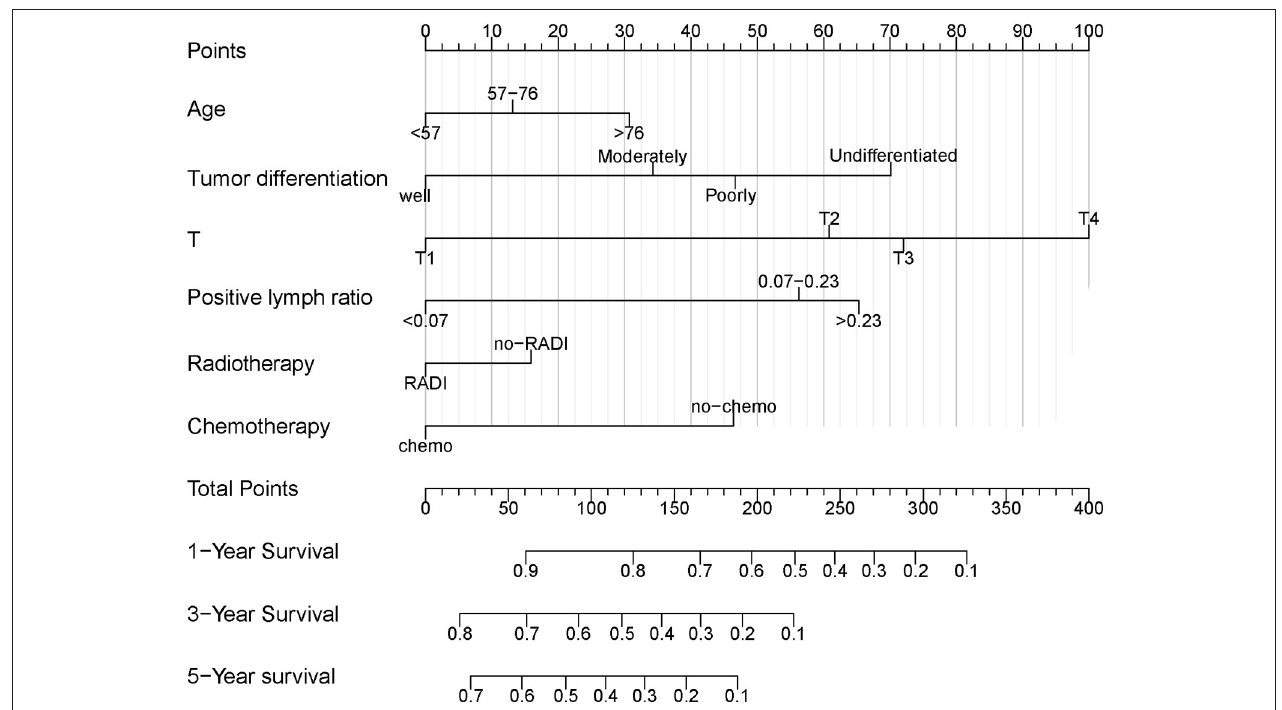
FIGURE 3 | Nomogram for predicting OS of PDAC patients treated with TP. OS, overall survival; PDAC, pancreatic ductal adenocarcinoma; TP, total pancreatectomy.